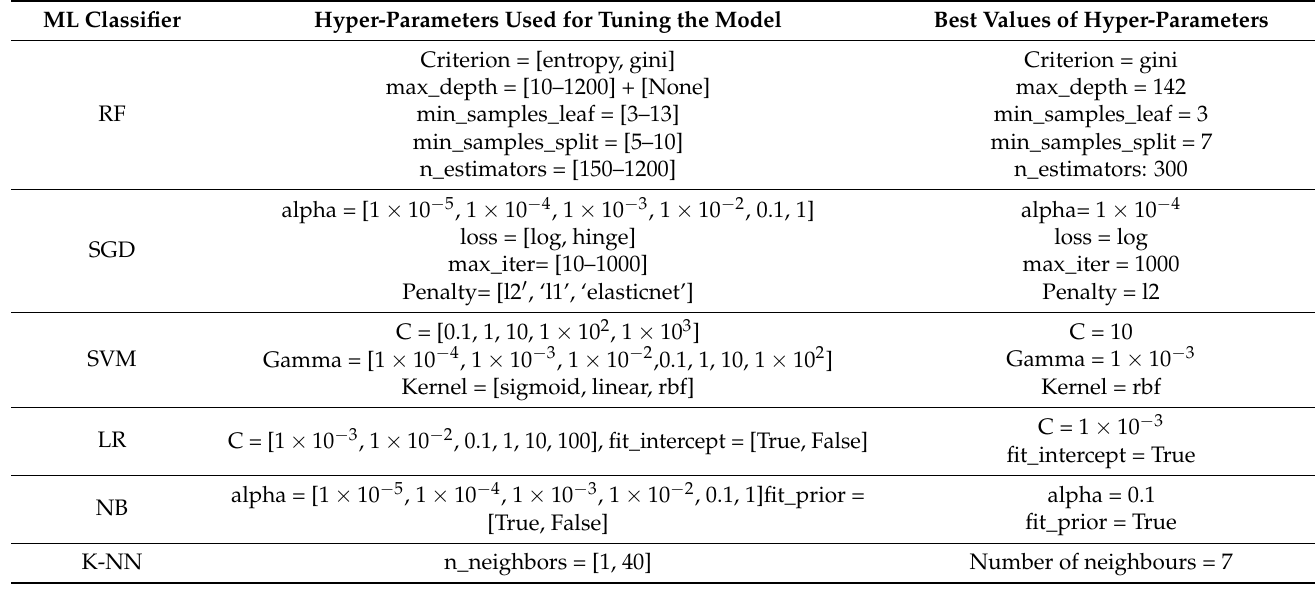
Table 7. List of optimized hyper-parameters of each classifier. ML Classifier Hyper-Parameters Used for Tuning the Model Best Values of